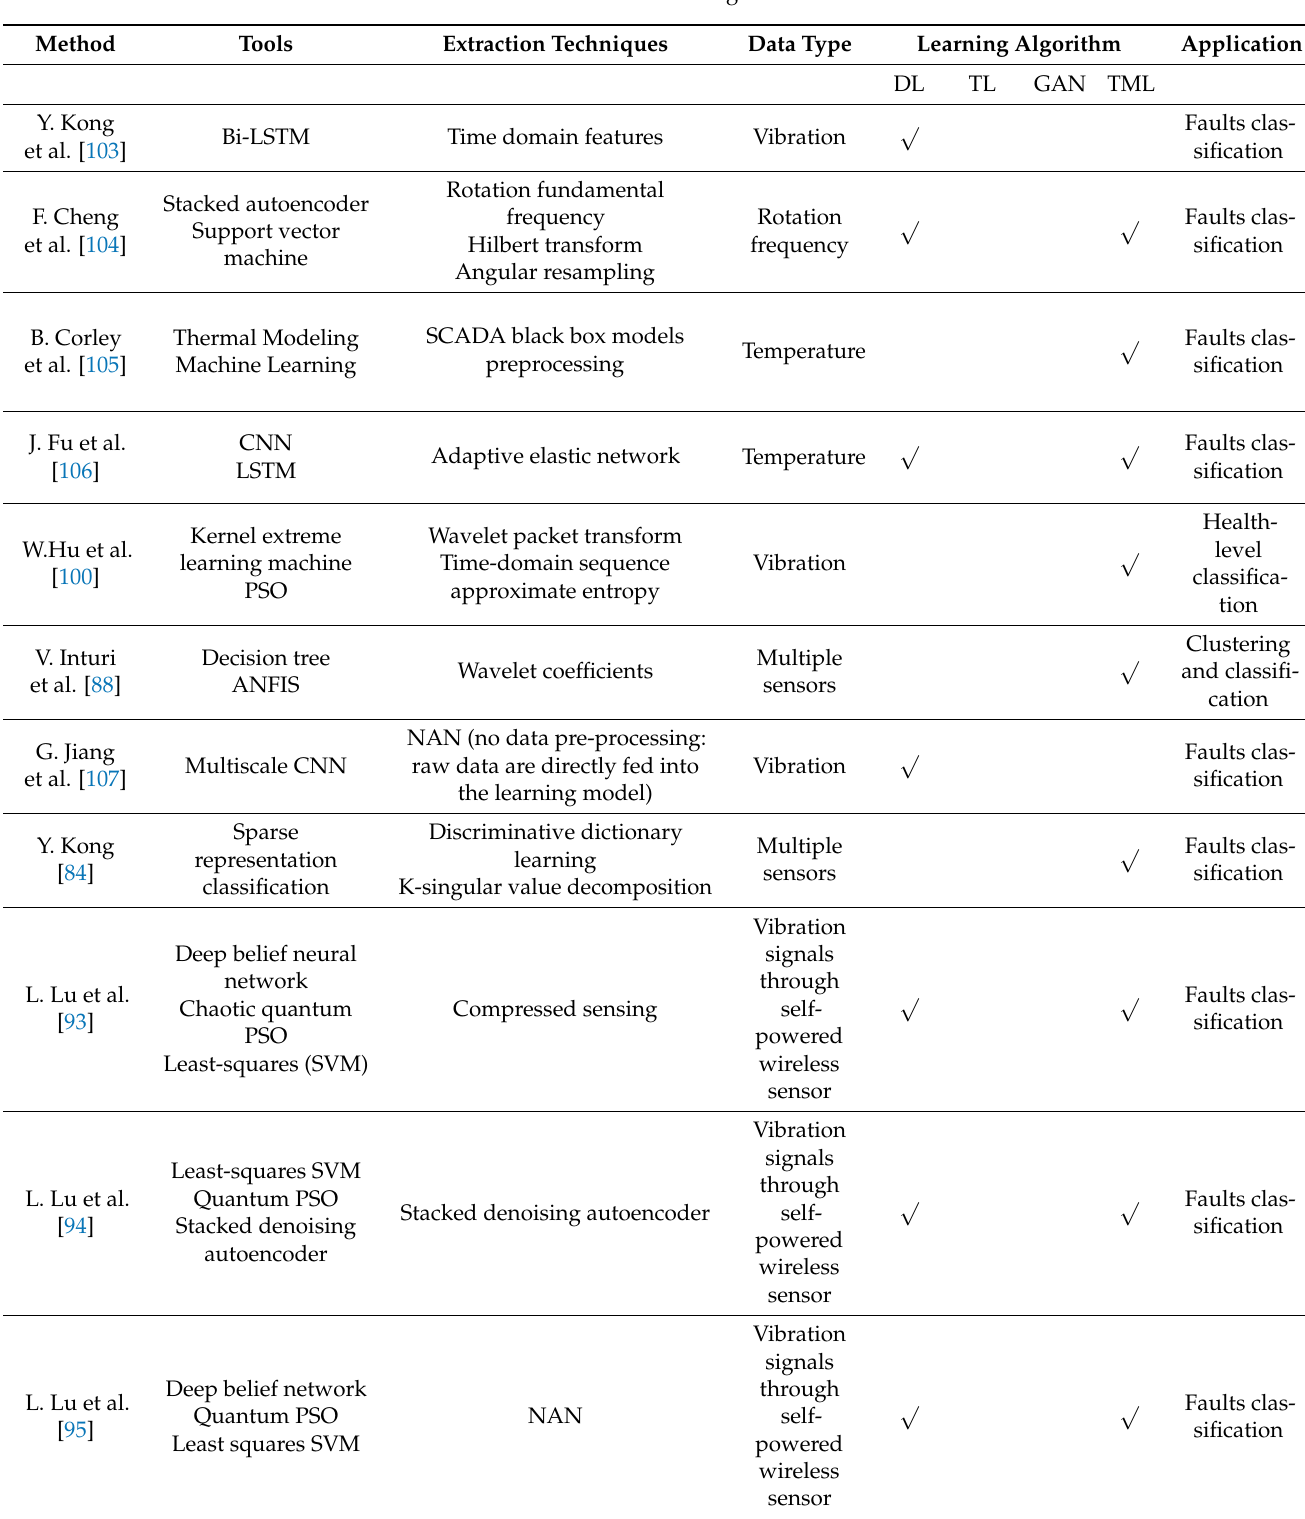
Table 2. Gearbox condition monitoring state of the art